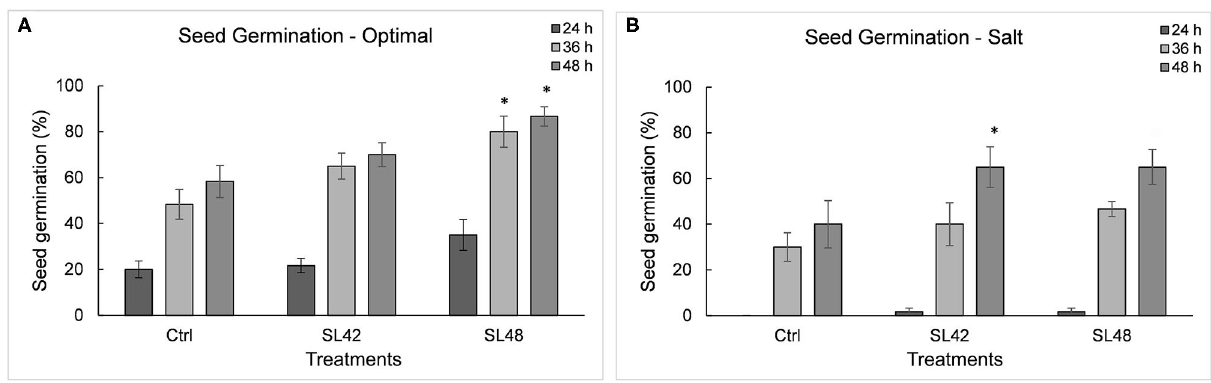
FIGURE 2 | Seed germination rate of soybean at 24, 36, and 48h under (A) optimal (water) and (B) salt (100mM NaCl) conditions. The seeds were treated with 10mM